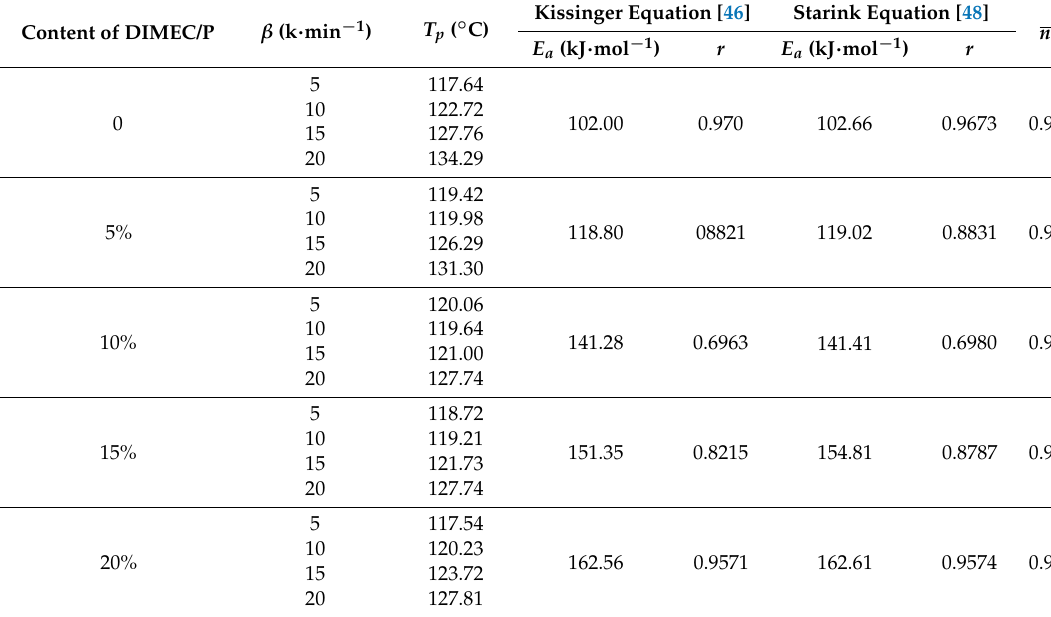
Table 1. The DSC data of